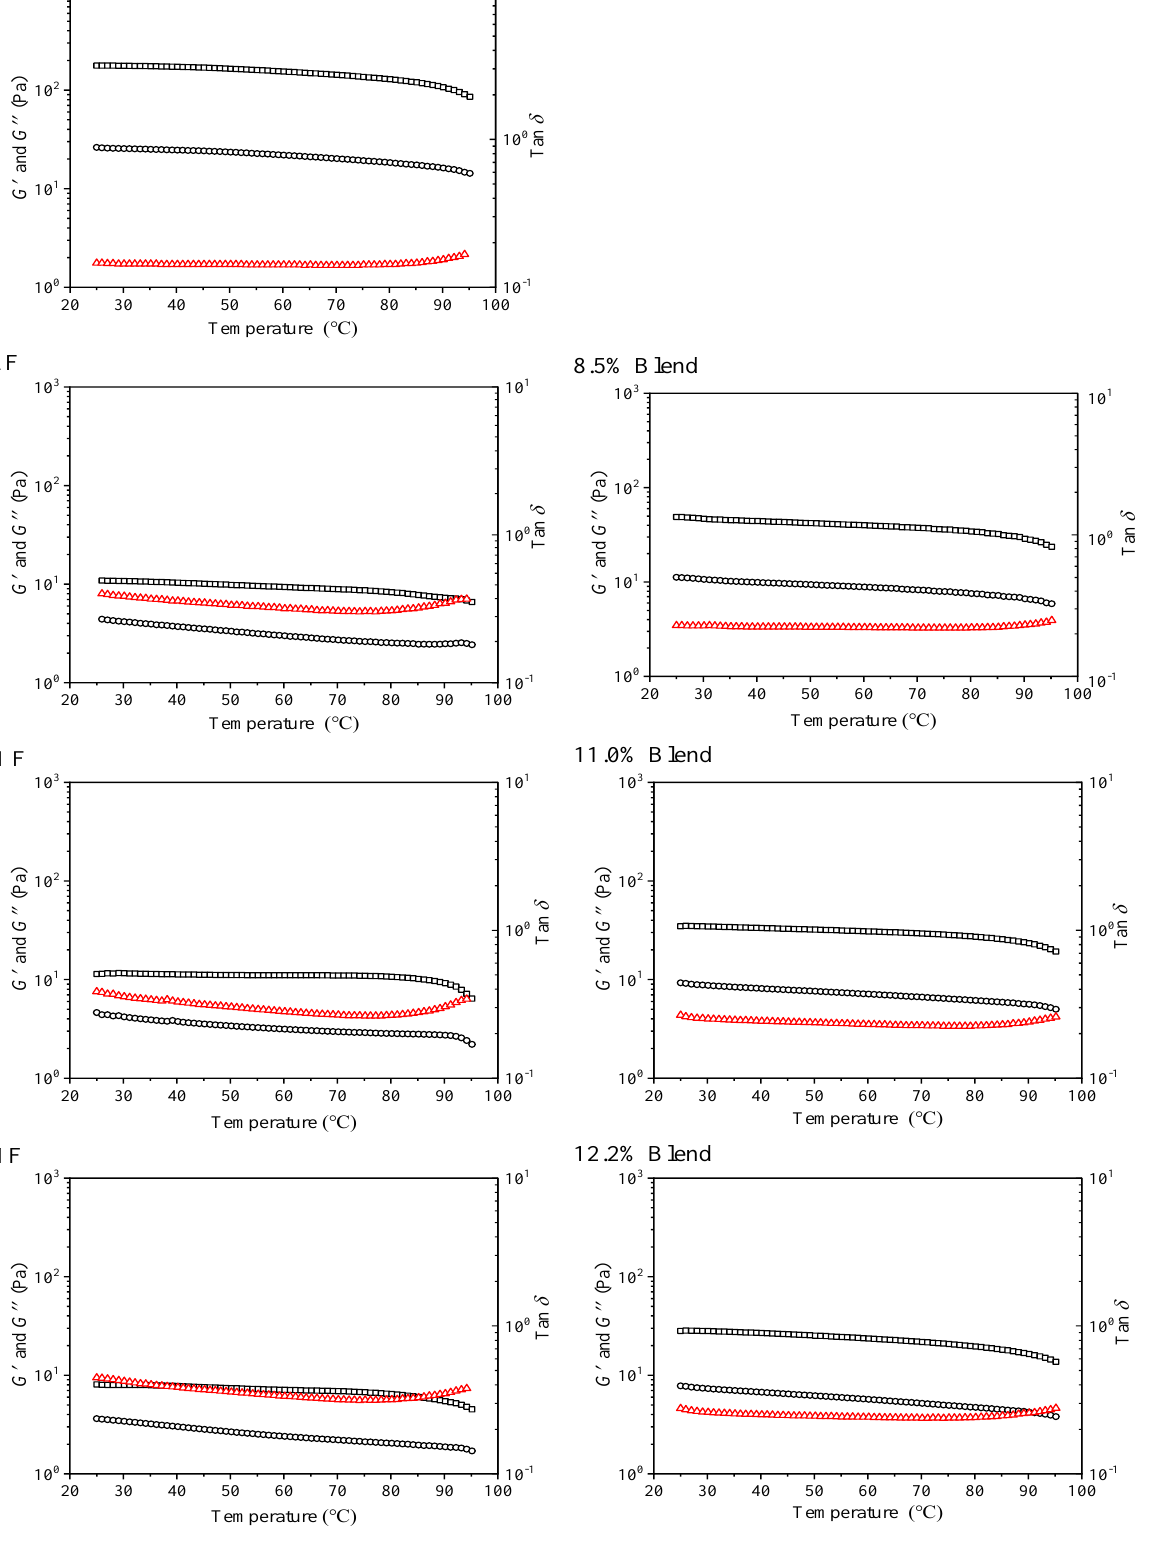
Figure 4. Storage modulus ( G (cid:48) , square), loss modulus ( G (cid:48)(cid:48) , circle), and tan (triangle) as a function of temperatures for the film-forming matrices of pure WS, wheat flours, and WS–gluten blends with different protein contents (8.5%, 11.0%, and